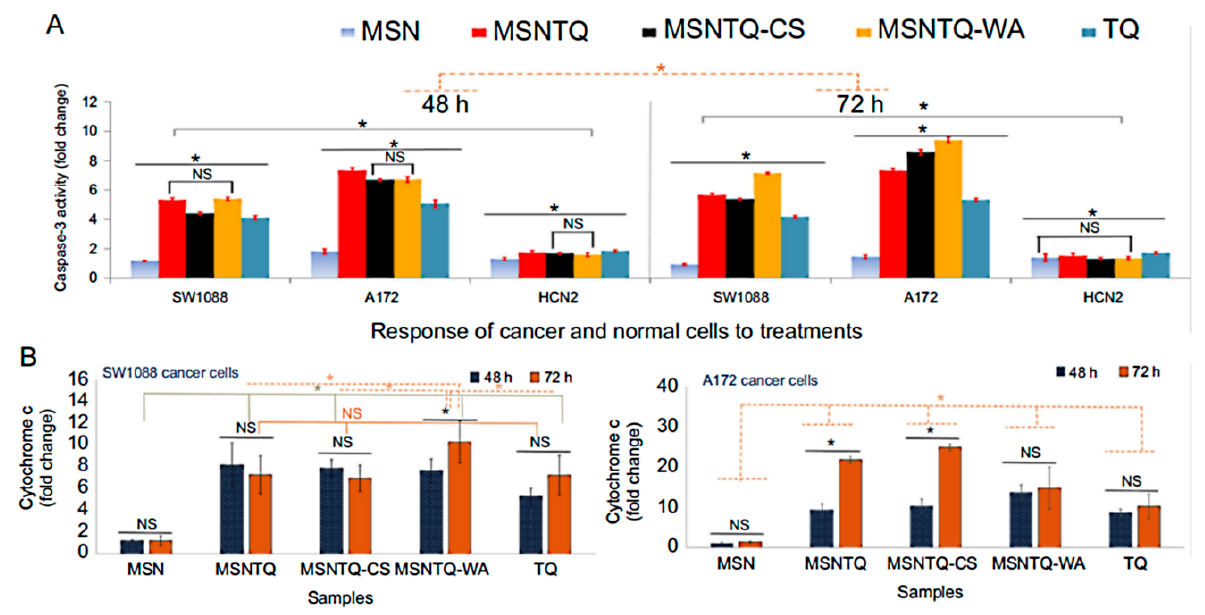
Figure 12. The molecular mechanisms of targets of core nanoformulation (MSNTQ), core–shell nanoformulations (MSNTQ-CS and MSNTQ-WA), and thymoquinone (TQ) in a free form on brain cancer cells (SW1088 and A172) and normal brain cells (HCN2) after 48 and 72 h of incubation. ( A ) Caspase-3 activation in the fold change measured by ELISA for all treatments, and ( B ) cytochrome c intracellular release in the fold change measured by RT-PCR for all treatments. All data are expressed as the mean ± standard deviation. The differences are expressed with * at p < 0.05 based on the least significant difference. Nonsignificant differences are marked as NS. In the case of caspase-3, the solid gray line indicates the significance between cell lines, and the dashed orange line indicates differences between incubation times. Reproduced from Ref. [99], Dove Medical Press Limited, an open-access source.